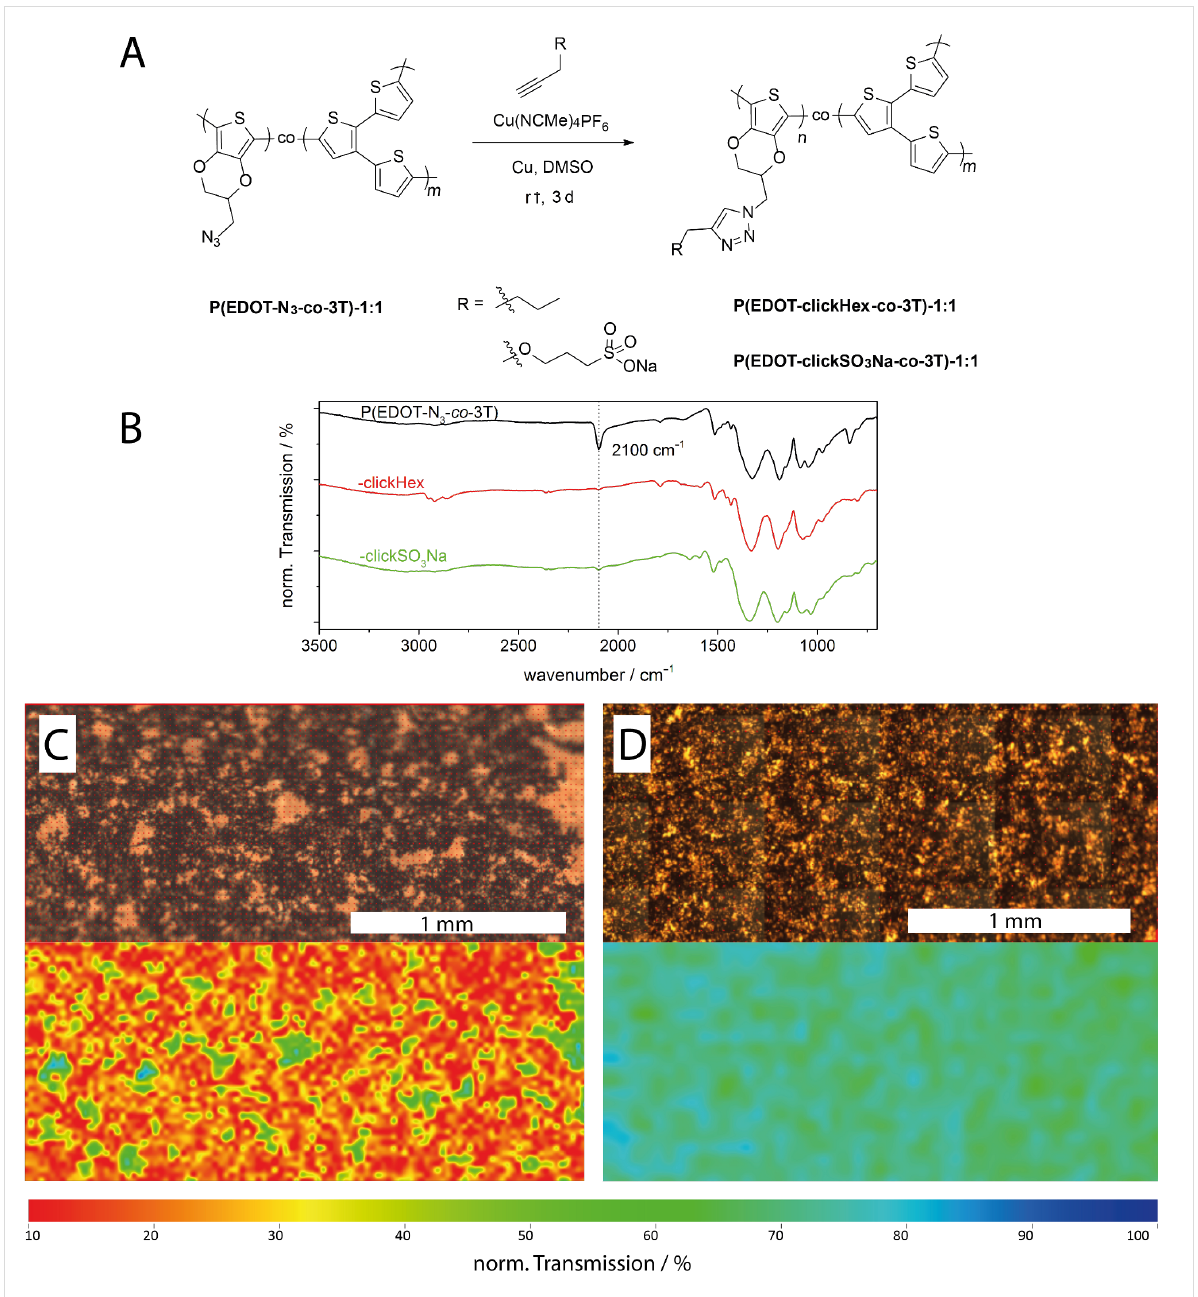
Figure 3: A: Modification of the copolymer films P(EDOT-N 3 -co- 3T) with 1-hexyne and alkyne sulfonate with [Cu(NCMe) 4 ]PF 6 and copper powder as catalyst in DMSO, reaction time 3 days at room temperature (rt). B: IR spectra of copolymer films P(EDOT-N 3 -co- 3T) (black line), P(EDOT-clickHex - co- 3T)-1:1 (red line, hexyl modification) and P(EDOT-clickSO 3 Na -co- 3T)-1:1 (green line, sulfonate modification); spectra were rescaled (y-offset) for comparison reasons. C, D: Microscope images (top) and IR mappings (bottom) of the azide band intensity at 2100 cm − 1 of copolymer films deposited under potentiostatic control on gold in 0.1 M NBu 4 PF 6 /MeCN. P(EDOT-N 3 -co- 3T)-1:1 (C, before modification) and P(EDOT-clickSO 3 Na -co- 3T) (D, after sulfonate modification). Spectra of the IR microscopy were normalized and plotted with identical colour ranges for comparison reasons.